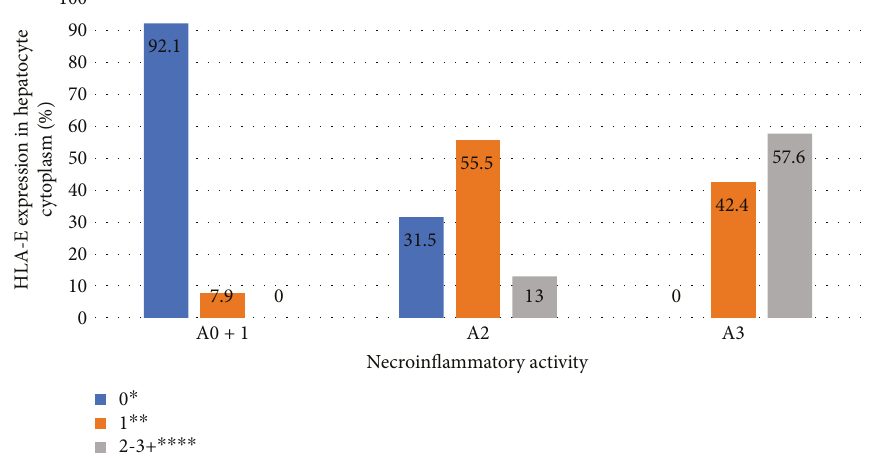
Figure 3: Association between HLA-E expression in hepatocyte cytoplasm and liver necroin fl ammatory activity. HLA-E expression was described in the following grades: 0 ∗ (without positive cell expression), 1+ ∗∗ ( < 25%), 2-3+ ∗∗∗∗ ( > 25 or > 50% of positive cell expression). Liver necroin fl ammatory activity was described according to the METAVIR classi fi cation: A0 +1: no or mild activity, A2: moderate activity, A3: severe activity. P < 0